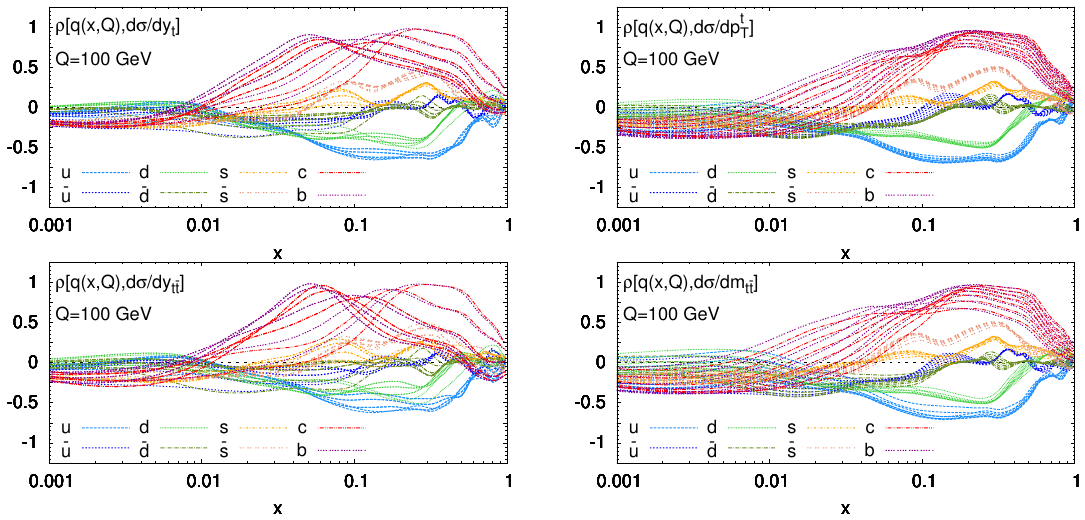
Figure 4 . Same as (cid:12)gure 3, but for quarks and antiquarks, q ( x; Q 2 ), q = u; (cid:22) u; d; (cid:22) d; s; (cid:22) s; c; b .